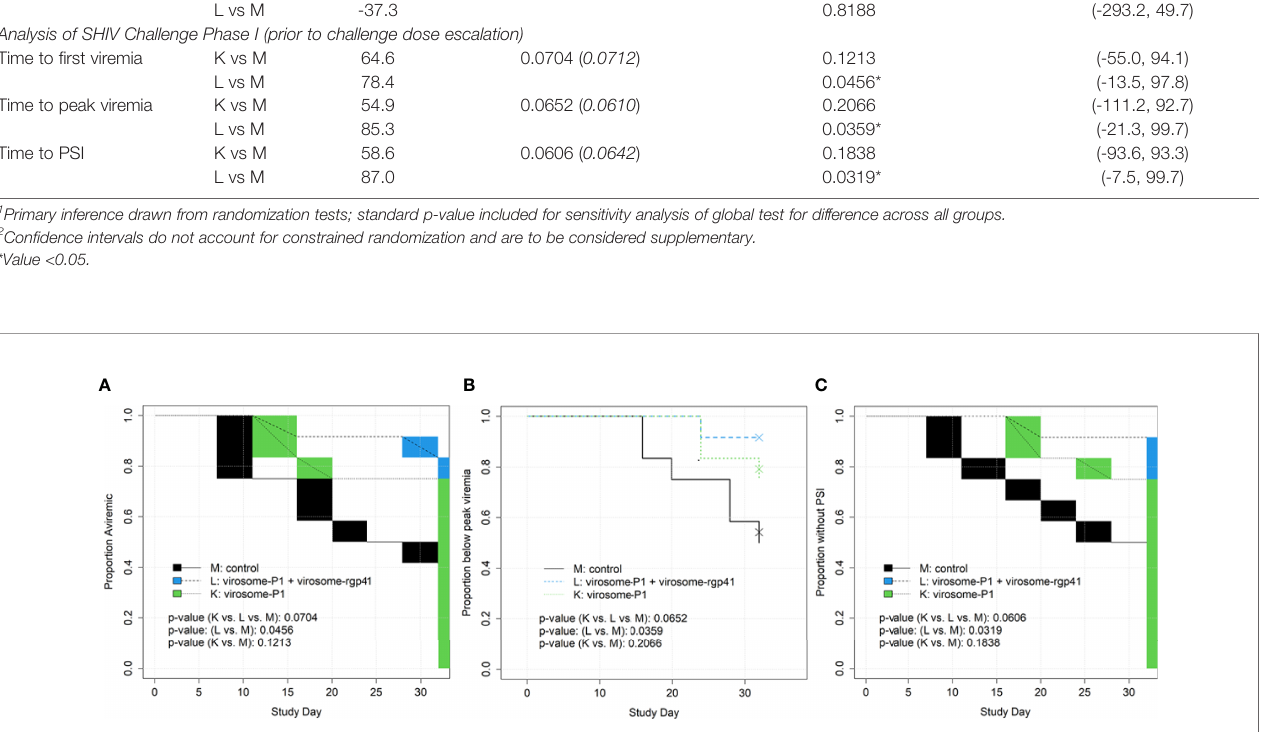
FIGURE 5 | Time to event endpoints, by study day, for SHIV Challenge Phase I (A – C) . This included the fi rst 7 challenges and the time up to but not including challenge #8, when the challenge virus dose was increased. Endpoints include (A) time to fi rst viremia; (B) time to peak viremia; and (C) time to persistent systemic infection (PSI). For interval-censored endpoints (time to fi rst viremia, time to PSI), blocks in fi gures indicate periods with no plasma samples taken, over which the time to event curve is linearly interpolated. There were no signi fi cant differences among Groups K, L, and M when the entire study was analyzed (Challenges Phases I and II; for a total of 22 SHIV challenges; data not shown). Statistical analyses were performed by Dr. Chris